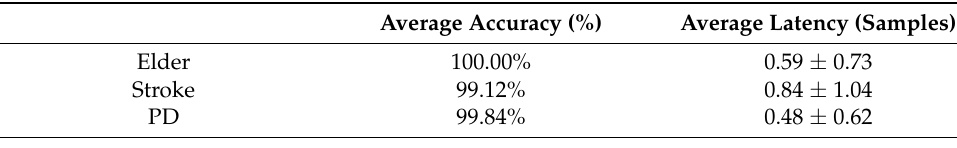
Table 2. Testing results of the RNN model [24].